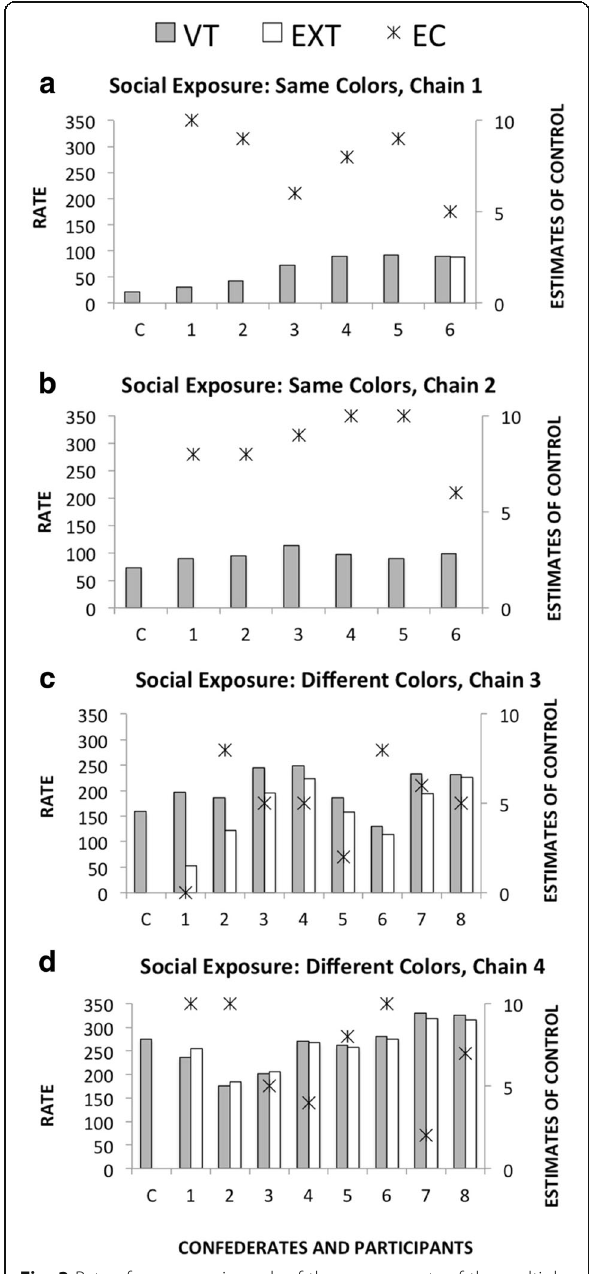
Fig. 3 Rate of responses in each of the components of the multiple schedule for each participant in the four experimental chains (Social Exposure [Same Colors], Chain 1 and Chain 2; Social Exposure [Different Colors], Chain 3 and Chain 4). The figures also show the estimates of control in each session. a Social Exposure: Same Colors, Chain 1. b Social Exposure: Same Colors, Chain 2. c Social Exposure: Different Colors, Chain 3. d Social Exposure: Different Colors, Chain